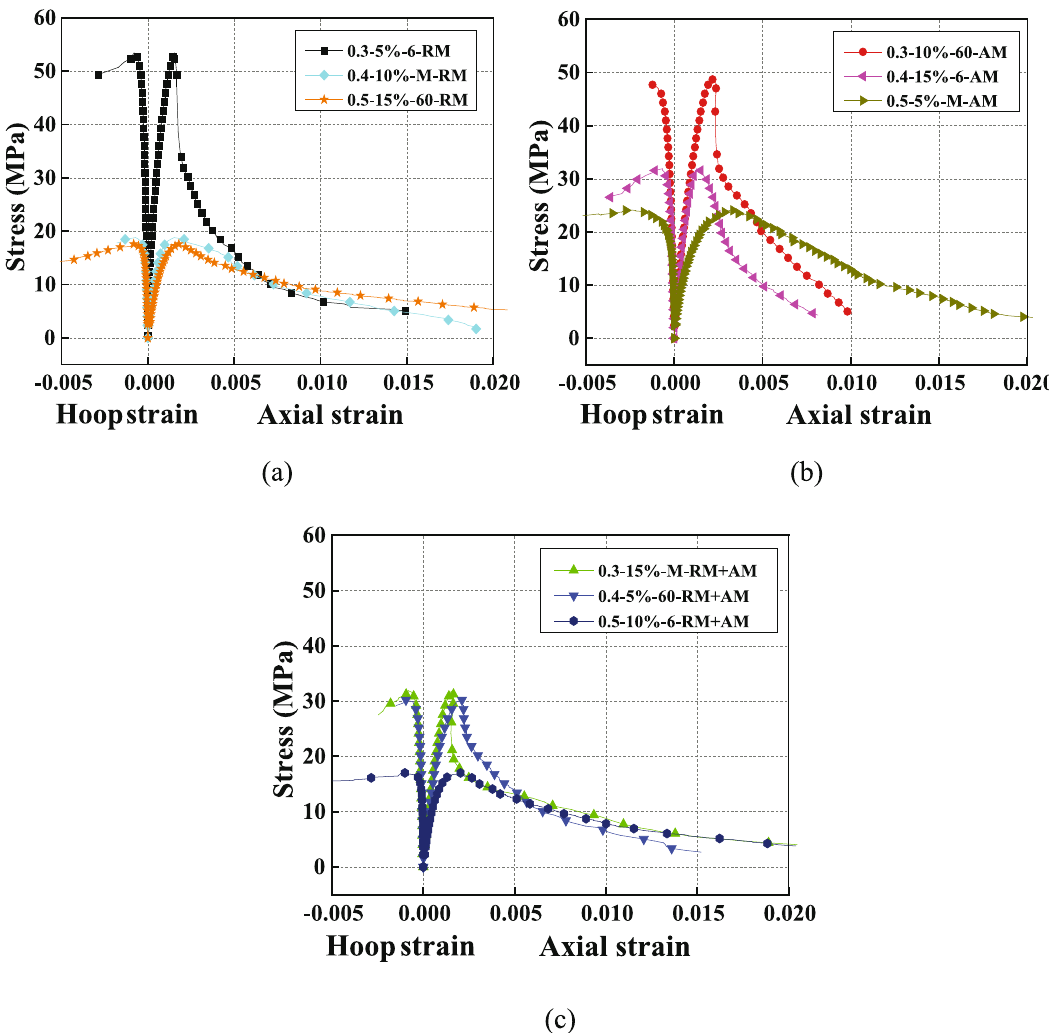
Figure 16: Stress – strain curves of RRAC with di ff erent aggregate treatment methods: ( a ) RM, ( b ) AM, and ( c ) RM and